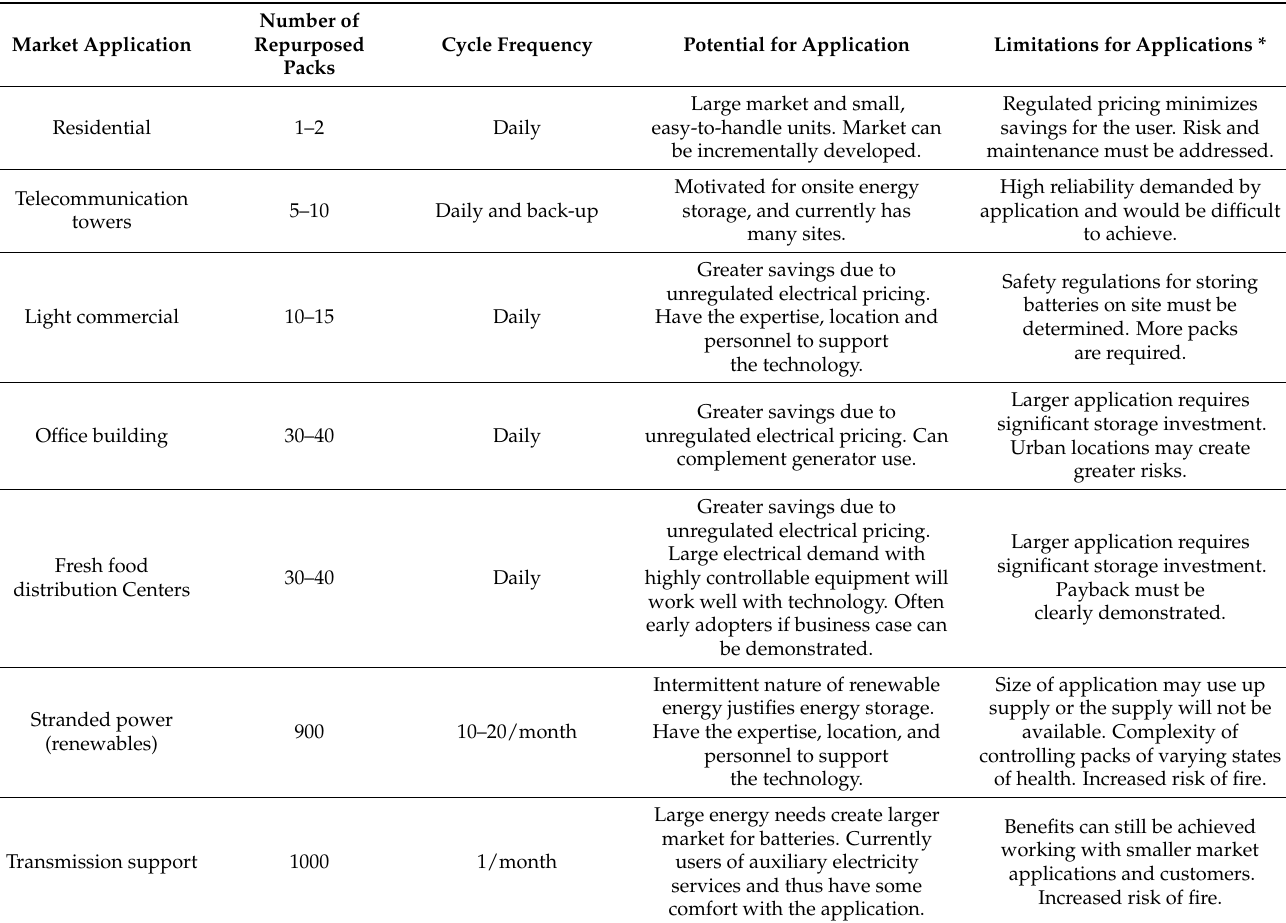
Table 4. Markets for 2nd life batteries [14].